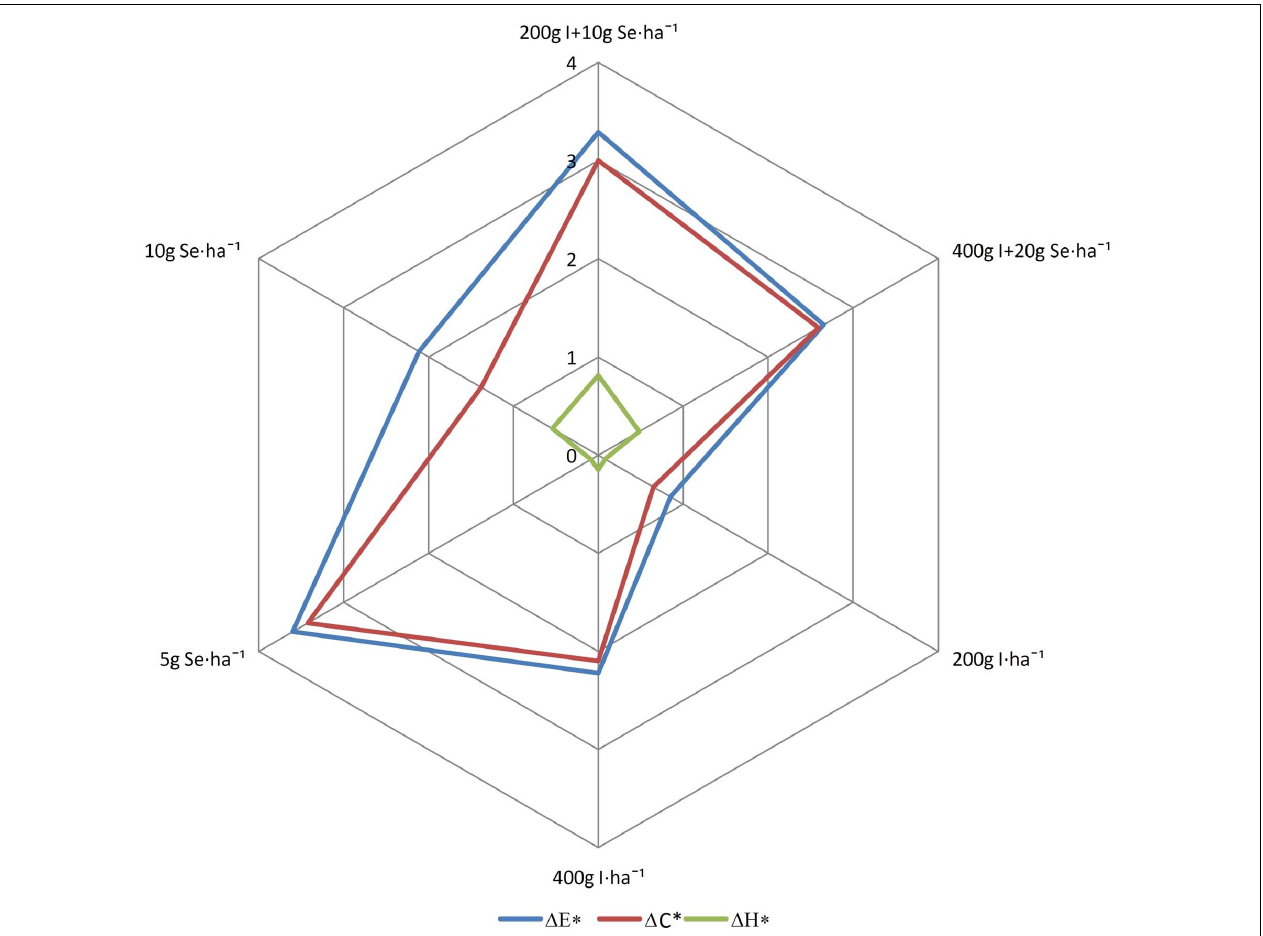
FIGURE 2 | Effect of biofortification on color indices: (cid:49) E ∗ , (cid:49) C ∗ , (cid:49) H ∗ . The mentioned parameters are calculated using the results of the average values of the basic parameters ( L ∗ , a ∗ , b ∗ , C ∗ ). In accordance to the guidelines of International Commission on Illumination, the parameter values of (cid:49) E ∗ , (cid:49) C ∗ , and (cid:49) H ∗ less than 2 indicate the lack of recognizable differences in the color by the observer; greater than 5 indicates the differences are clear and visible to any observer. Where (cid:49) E ∗ , total color difference; (cid:49) C ∗ , total saturation difference; (cid:49) H ∗ , total hue difference. Application 200 g I + 10 g Se · ha − 1 and 400 g I + 20 g Se · ha − 1 by “I + Se” fertilizer, application of 200 g and 400 I · ha − 1 by “Solo iodine” fertilizer, and application 5 g and 10 g Se · ha − 1 by “Solo selenium” ·